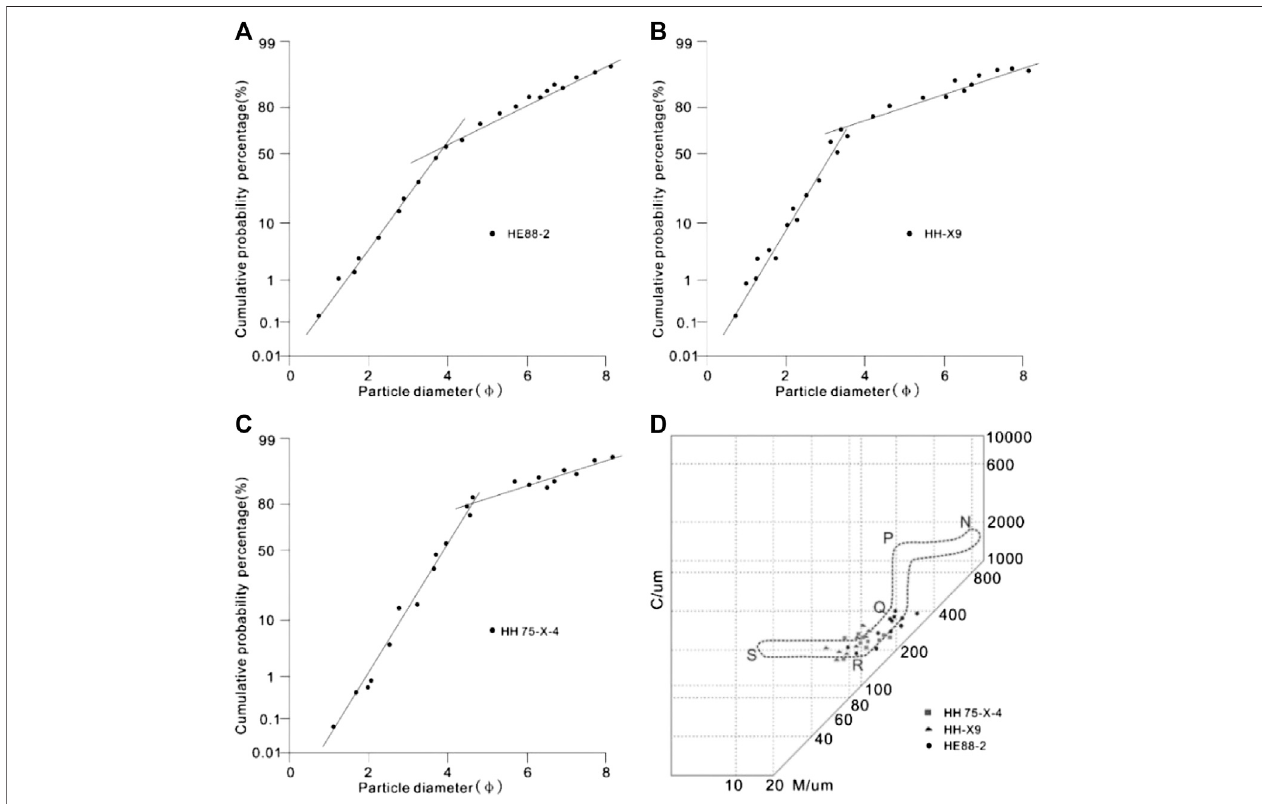
FIGURE 5 | Grain size cumulative probability curve and C-M diagram of sandstone: (A – C) cumulative curve of grain size probability and (D) the C-M diagram of different samples of three core wells.